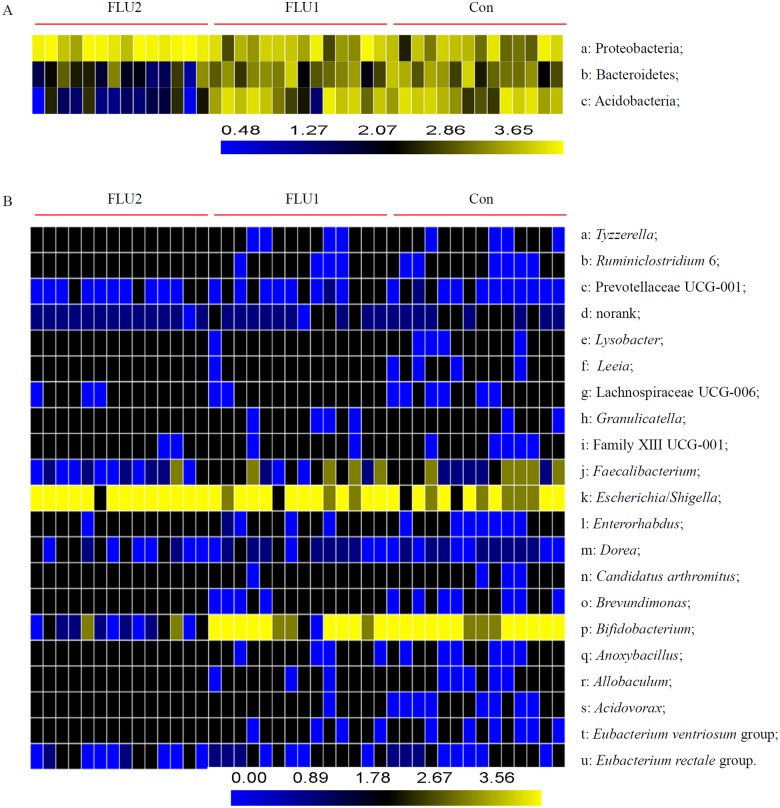
Relative abundance of individual gut microbiota composition at different taxonomic rank.Heatmap visualizes logarithm (base-10) of ratios (p<0.05). A Phyla found to be statistically different among the three groups. B Genera found to be statistically different among the three groups.